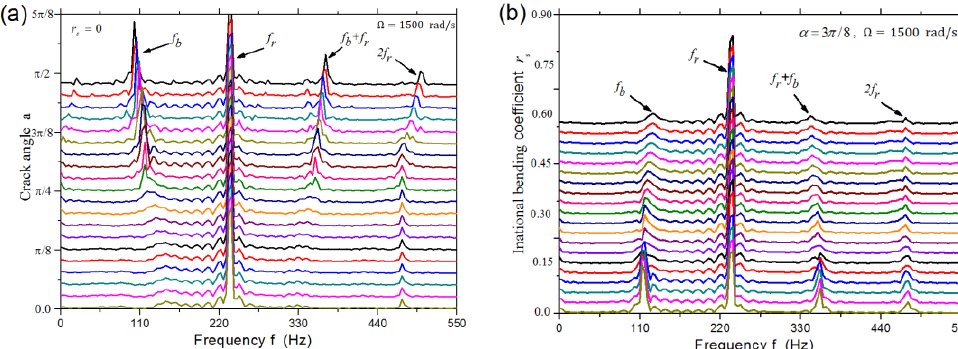
Figure 7. Spectrogram of dynamic response affected by crack angle and initial bending. ( a ) spectrogram with growth of crack, ( b ) spectrogram with growth of initial bending.